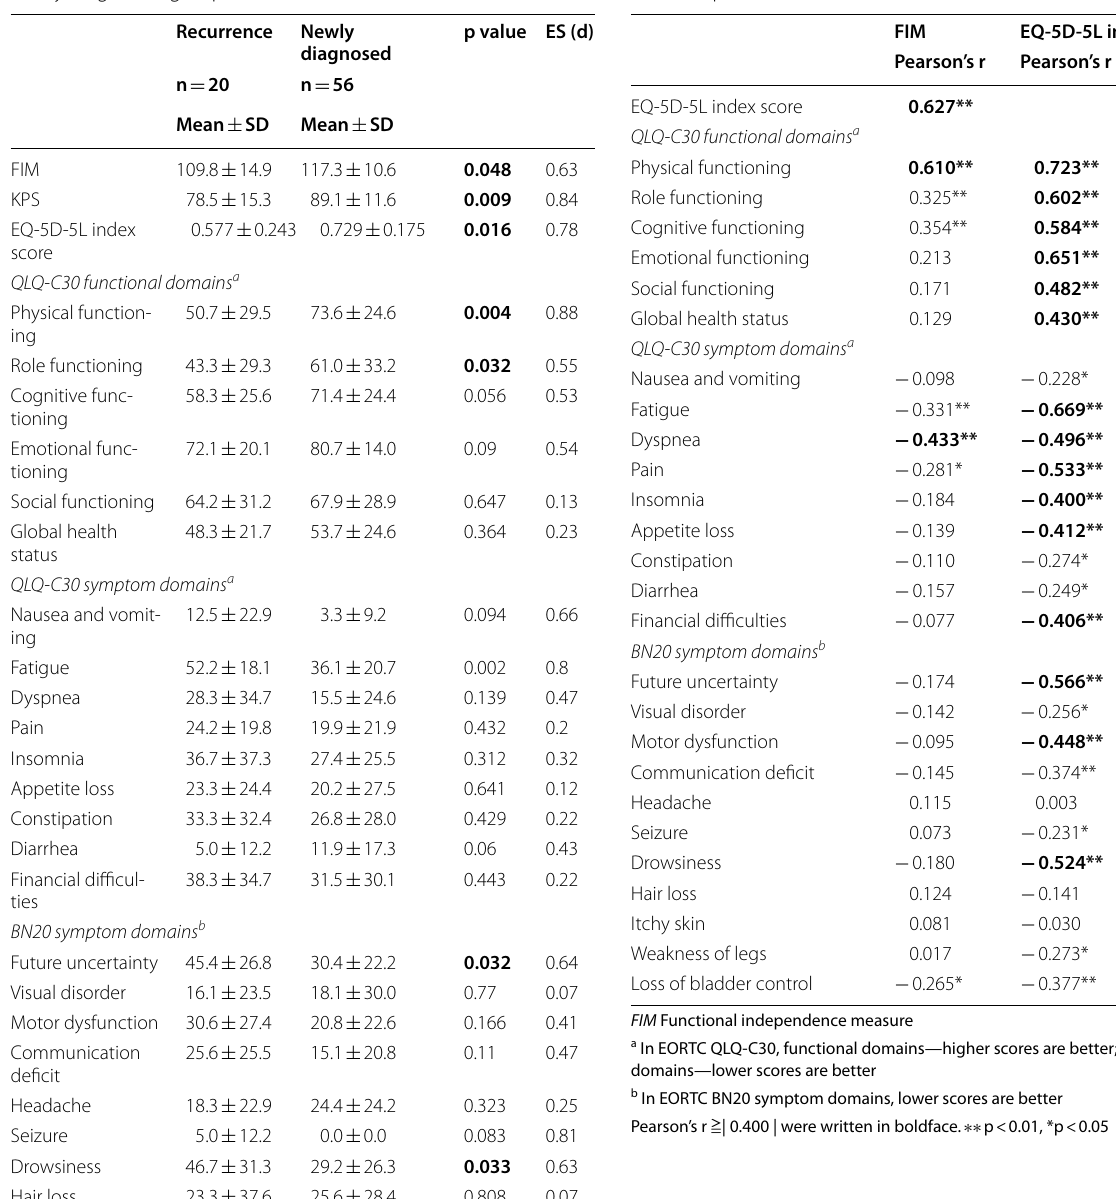
Table 3 Comparison of FIM, KPS, and HRQOL by recurrence and newly diagnosed groups